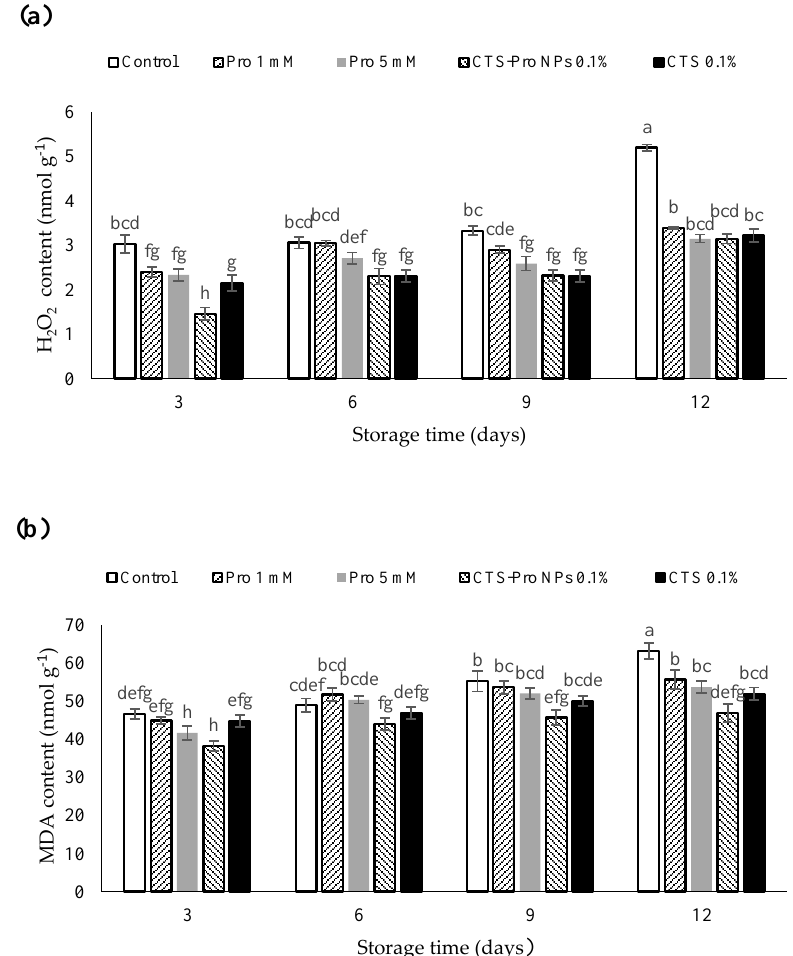
Figure 2. Effect of post–harvest treatments of strawberries with Pro, CTS and CTS–P NPs on ( a ) H 2 O 2 and ( b ) MDA accumulation during 12 days of storage at 4 ◦ C. Data presented are mean ± standard error (SE) of three replications. Different letters (a–h) over bars indicate they are significantly different ( p < 0.05) by Duncan’s